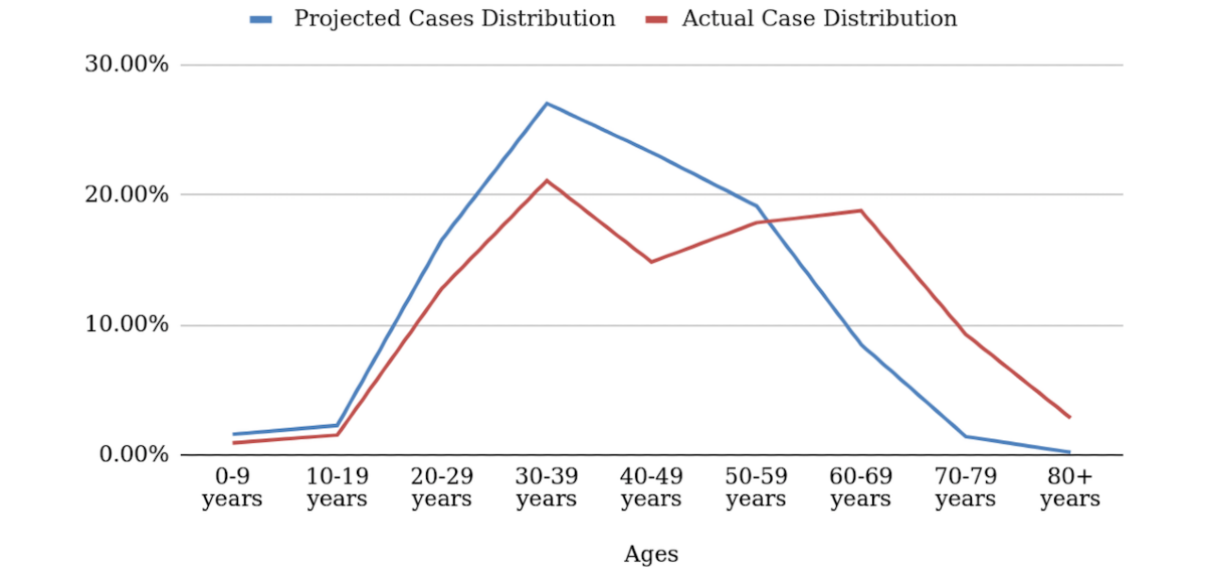
Figure 4. Projected versus actual age-stratified case distribution for Quezon